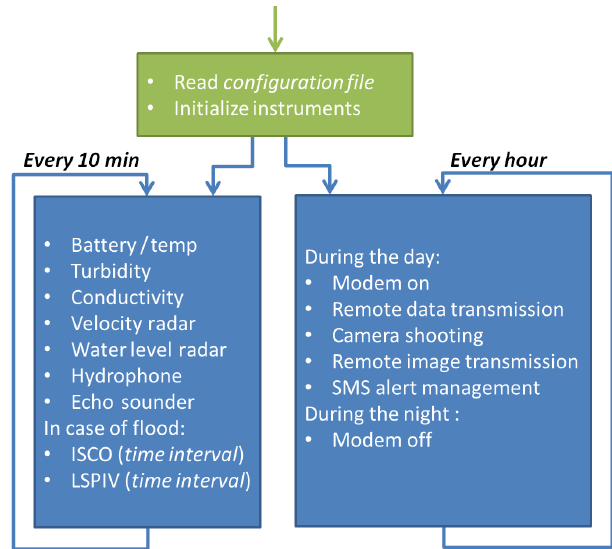
Figure 5. Architecture of the main program that controls the RIPLE